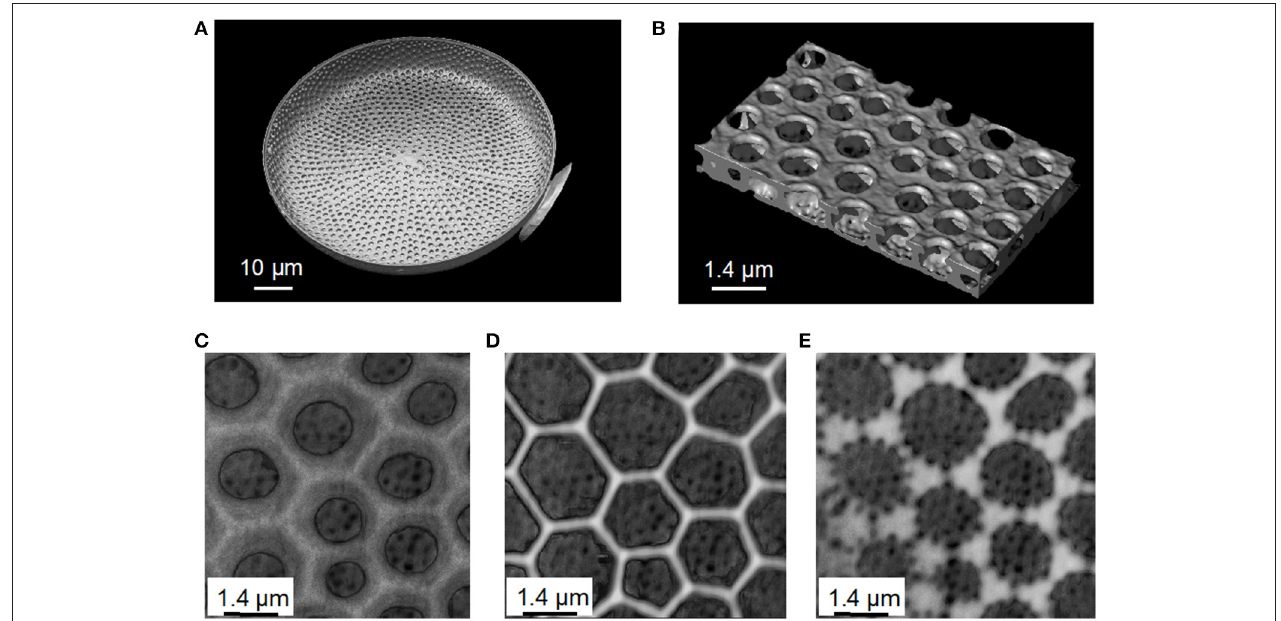
FIGURE 3 | Images of Coscinodiscus sp . diatom valve from X-Ray tomography data obtained at the European Synchrotron Radiation Facility (ESRF). (A) A complete valve view from the cellular face. On the right we see part of the needle used as a support to handle and rotate the valve face to the X-Ray beam. (B) 3D reconstruction image of the structure of the valve, where the up-side, foramen, is in the interior side of the cell. Foramen represents a periodic pores layer leading to a hexagonal network. (C) The areola layer connecting the Foramen (big holes inside the valve) to the cribrum. (D) The cribrum layer of the valve. (E) The cribellum